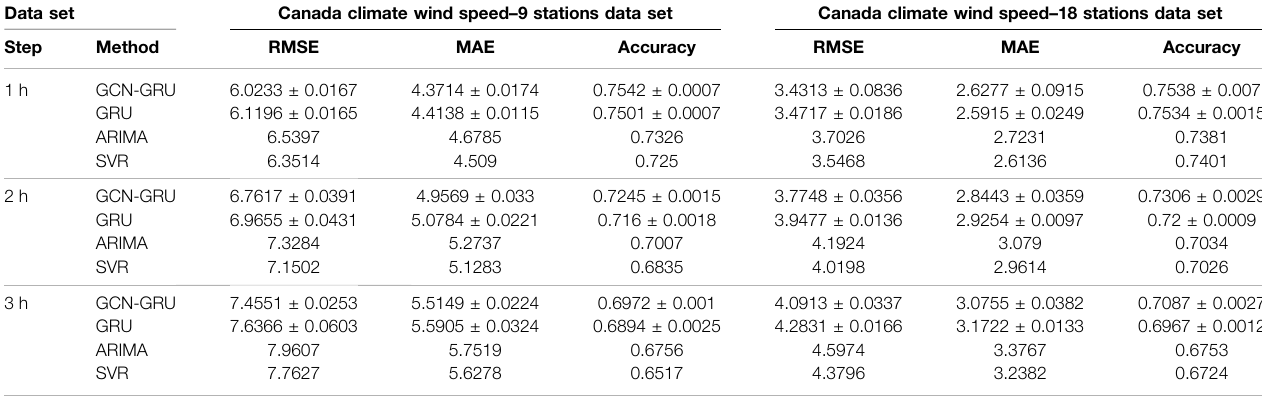
TABLE 4 | The average value of prediction results of all wind stations in Canada Climate wind speed experiments. Data set